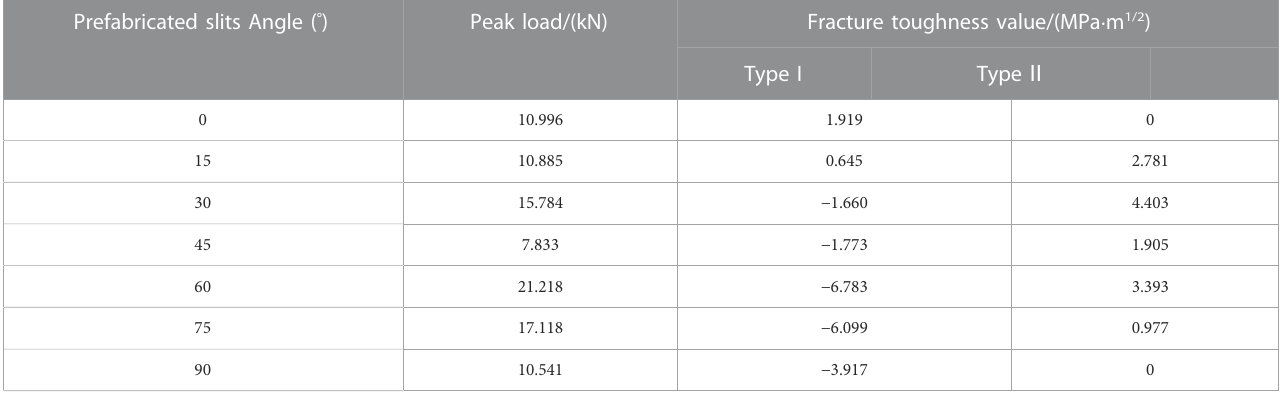
TABLE 3 Calculation results of fracture toughness values. Prefabricated slits Angle ( ° )